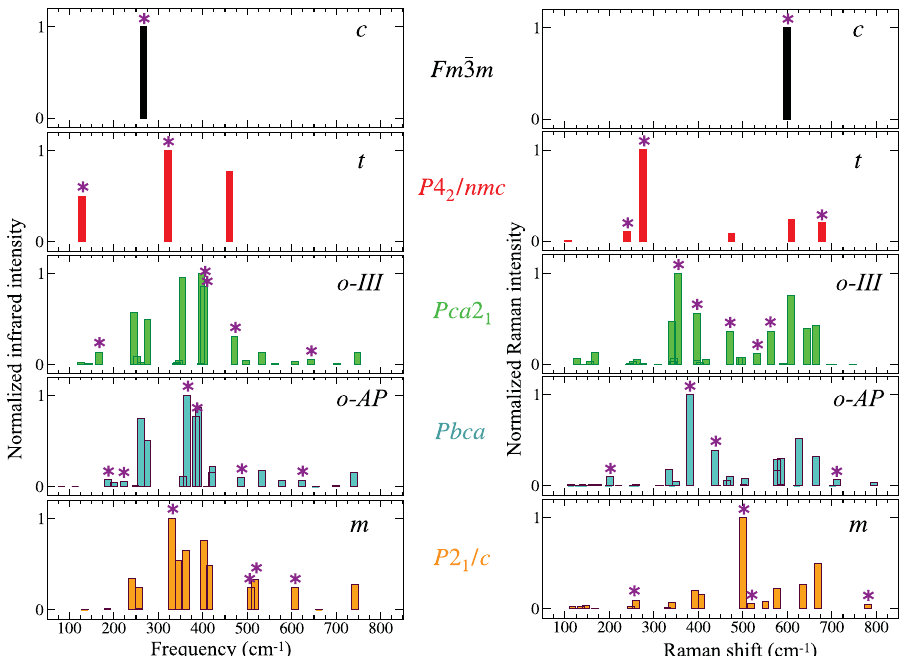
Fig. 4 Spectroscopic fi ngerprints of different phases of HfO 2 . Summary of the calculated (DFT-PBEsol) infrared and Raman responses for the fi ve studied phases of pure hafnia, i.e., cubic (c), tetragonal (t), orthorhombic polar (o-III), orthorhombic antipolar (o-AP), and monoclinic (m). For clarity, only TO infrared modes are provided in the calculated infrared spectra. LO mode details are available in the Supplementary Information. The signature modes for each phase are marked using